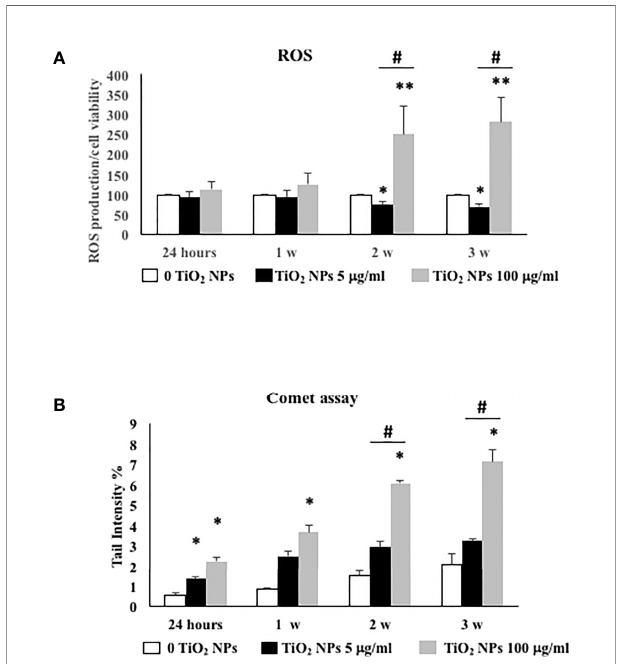
FIGURE 6 | ROS production and DNA damage under TiO 2 NPs treatment in SCs. (A) Total intracellular ROS production in SCs exposed to TiO 2 NPs 5 (black bar) and 100 µg/ml (grey bar) for 24 h and 1, 2, and 3 weeks. Data represent the mean ± SEM (* p < 0.05, ** p < 0.001, with respect to unexposed SCs (black dotted line) and # p < 0.05 vs. 5 m g/ml of TiO 2 NPs of three independent experiments, n = 8). (B) DNA damage expressed as tail intensity % in unexposed SCs (white bar) and exposed to TiO 2 NPs 5 (black bar) and 100 µg/ml (grey bar) for 24 h and 1, 2, and 3 weeks. Data represent the mean ± SEM (* p < 0.05, ** p < 0.001 vs. unexposed SCs and # p < 0.05 vs. 5 m g/ml of TiO 2 NPs of three independent experiments, n =